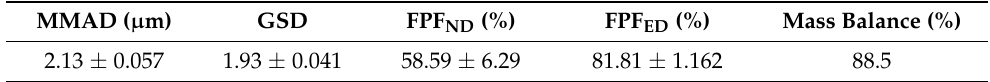
Table 3. ATRA-PLGA nanoparticles aerodynamic properties. Particles were nebulized with Aerogen Solo VMN. Results are shown for three independent nebulization runs (n = 3), mean ± SD, of nanoparticles suspended in 1 mL of saline solution. MMAD: mass median aerodynamic diameter; GSD: geometric standard deviation; FPF ND : fine particle fraction of nominal dose; FPF ED : fine particle fraction of emitted